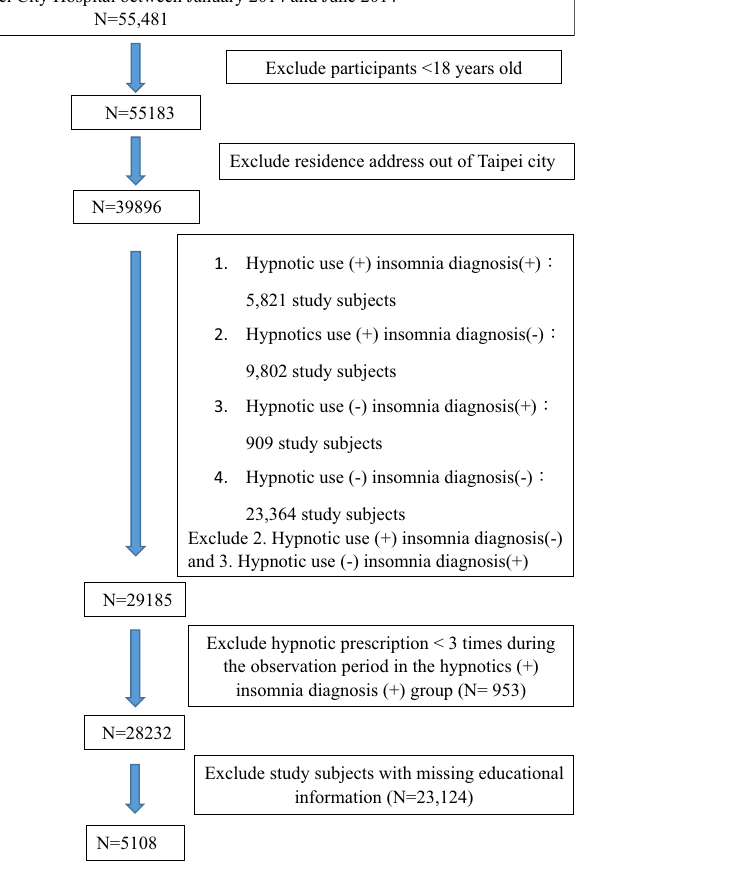
Figure 1. Flow chart of